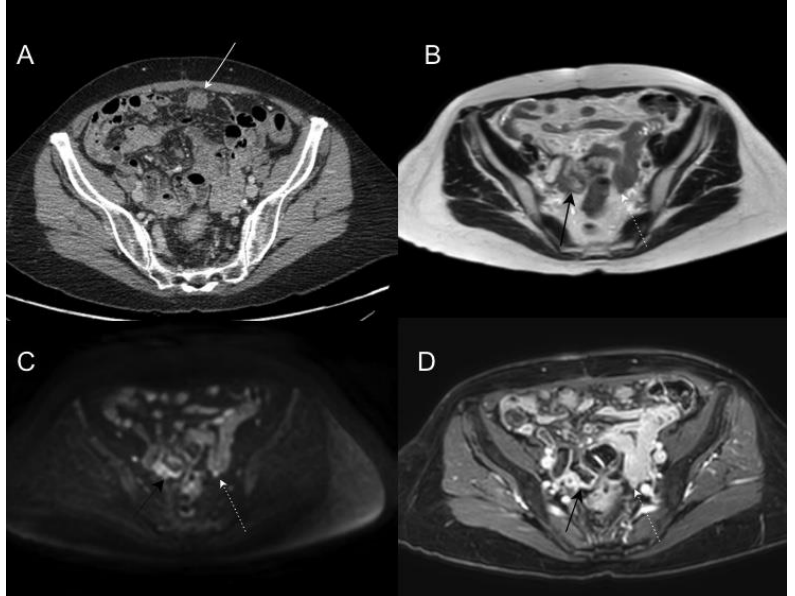
Figure 3. Portal phase contrast-enhanced CT axial image ( A ) shows mesenteric fat stranding and soft tissue mesenteric nodules (white arrow). In T2WI axial ( B ), DWI b1000 axial ( C ), and postGd DIXON axial ( D ) MR images, we can identify smaller soft tissue nodules, some of them laying on bowel surface (white dotted arrows) best depicted in DWI, and others with associated with focal bowel wall thickening (black arrows), with enhancement and restricted diffusion as a sign of serosal involvement.